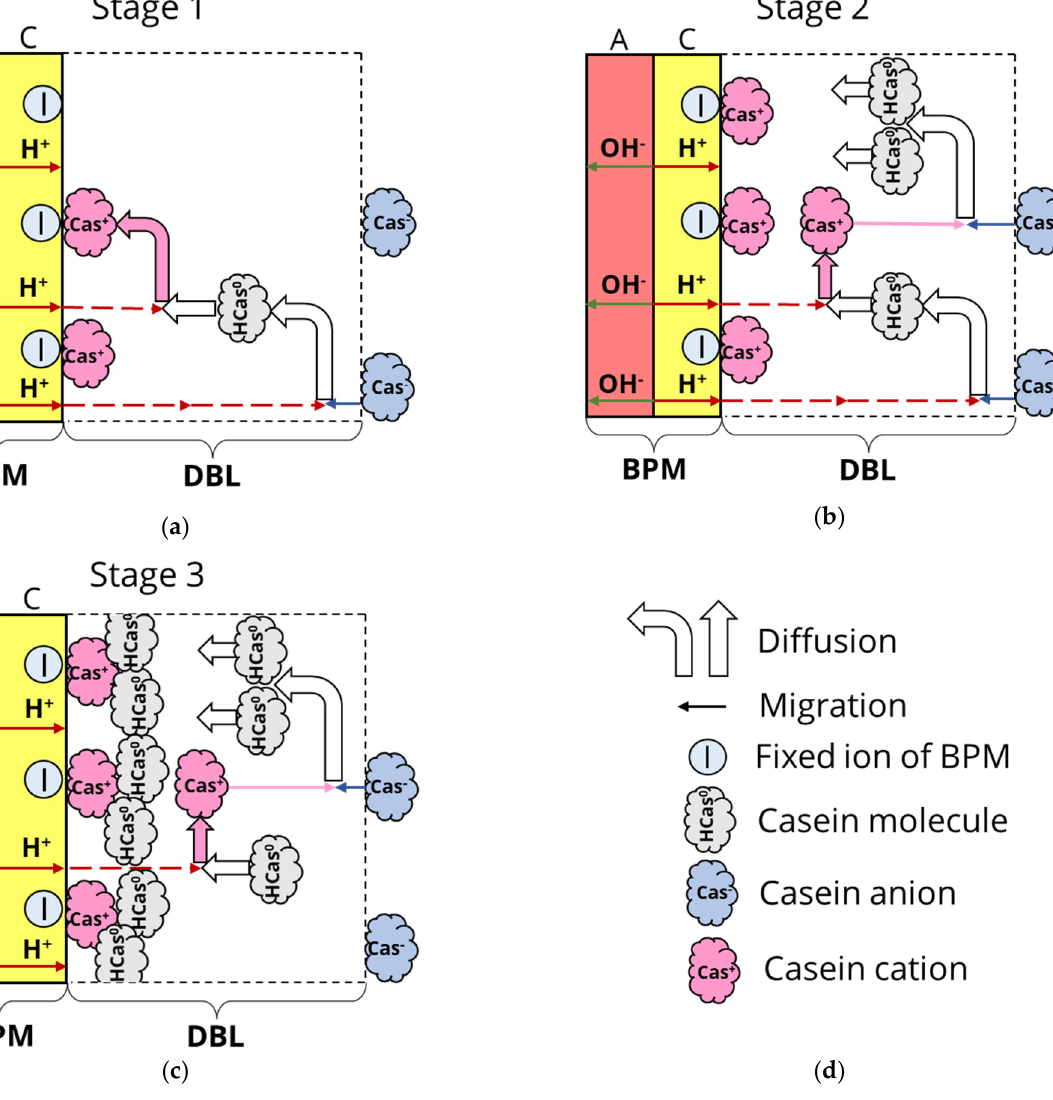
Figure 3. A schematic representation of the deposit formation at the cation-exchange surface of the BPM. Stage 1 ( a ): formation of casein cations (Cas + ) caused by interactions of casein species Cas − and/or HCas 0 with protons. Stage 2 ( b ): filling the cation-exchange surface with a dense layer of casein cations; accumulation of casein molecules HCas 0 in DBL. Stage 3 ( c ): formation of the loose deposit layer due to hydrogen bonds and hydrophobic interactions of HCas 0 with an already formed dense deposit layer. ( d ) is a legend for this scheme. Explanations are given in the text.